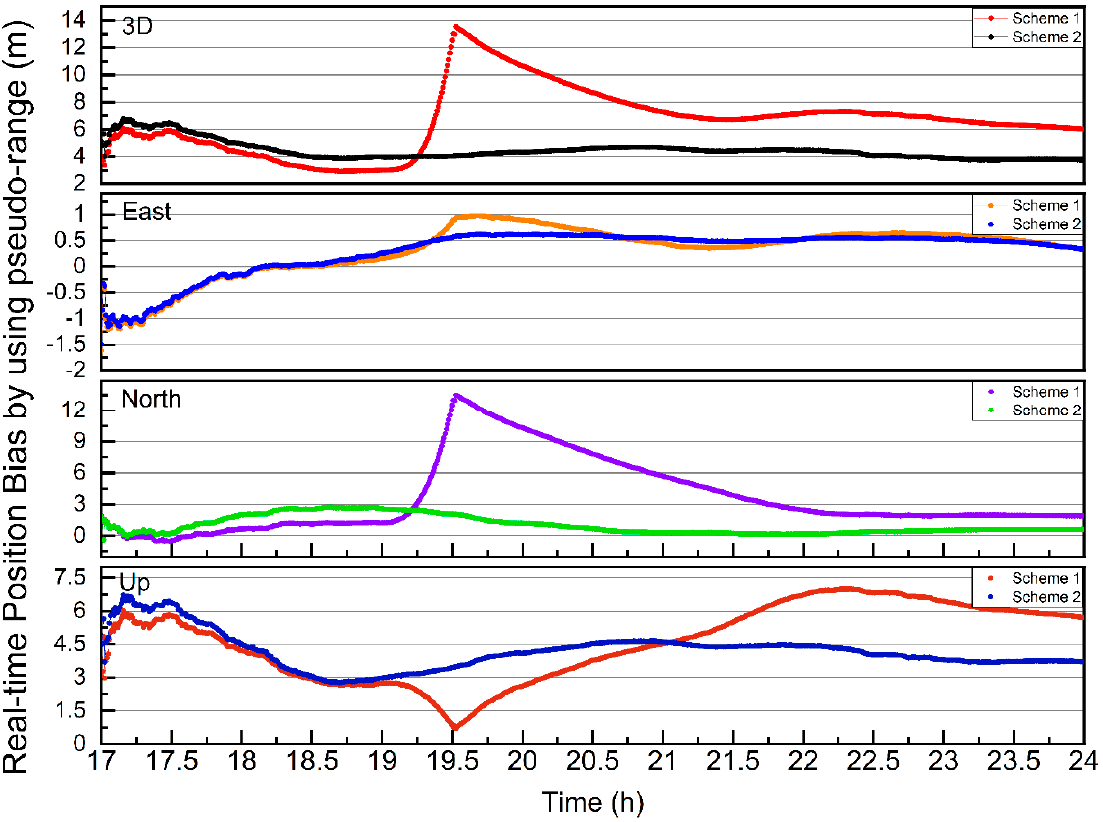
Figure 15. Results of real-time positioning by using ionosphere-free code observations. In Figure 15, the x-axis is the epoch time and the y-axis is the value of